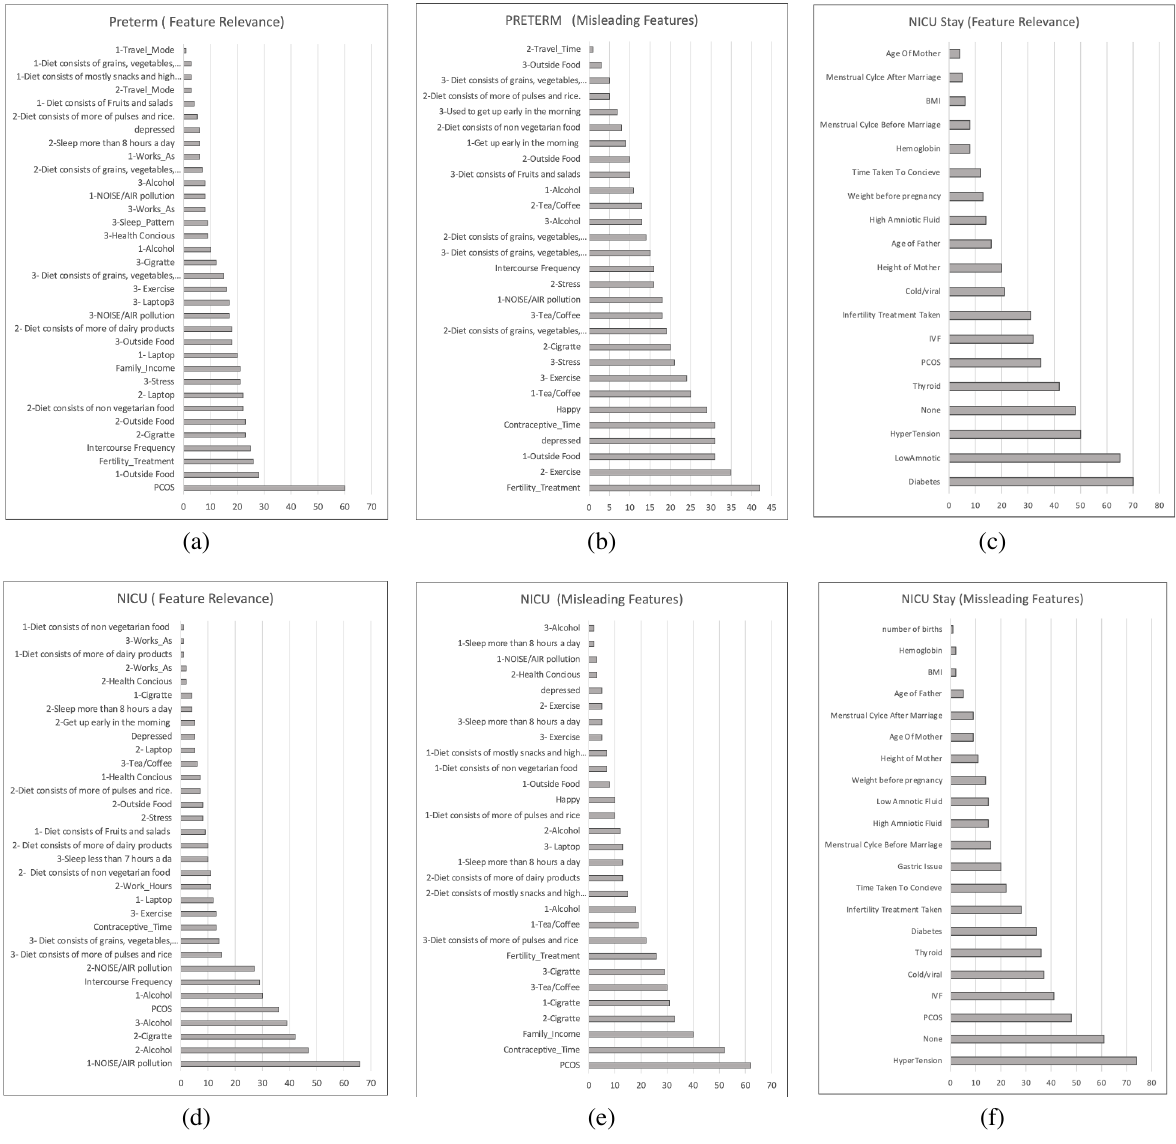
Fig. 2: Weight assigned to features (a),(b) lifestyle feature relevance and misclassification for preterm birth prediction, (d),(e) lifestyle feature relevance and misclassification for NICU prediction, (c), (f) physical feature relevance and misclassification for preterm birth